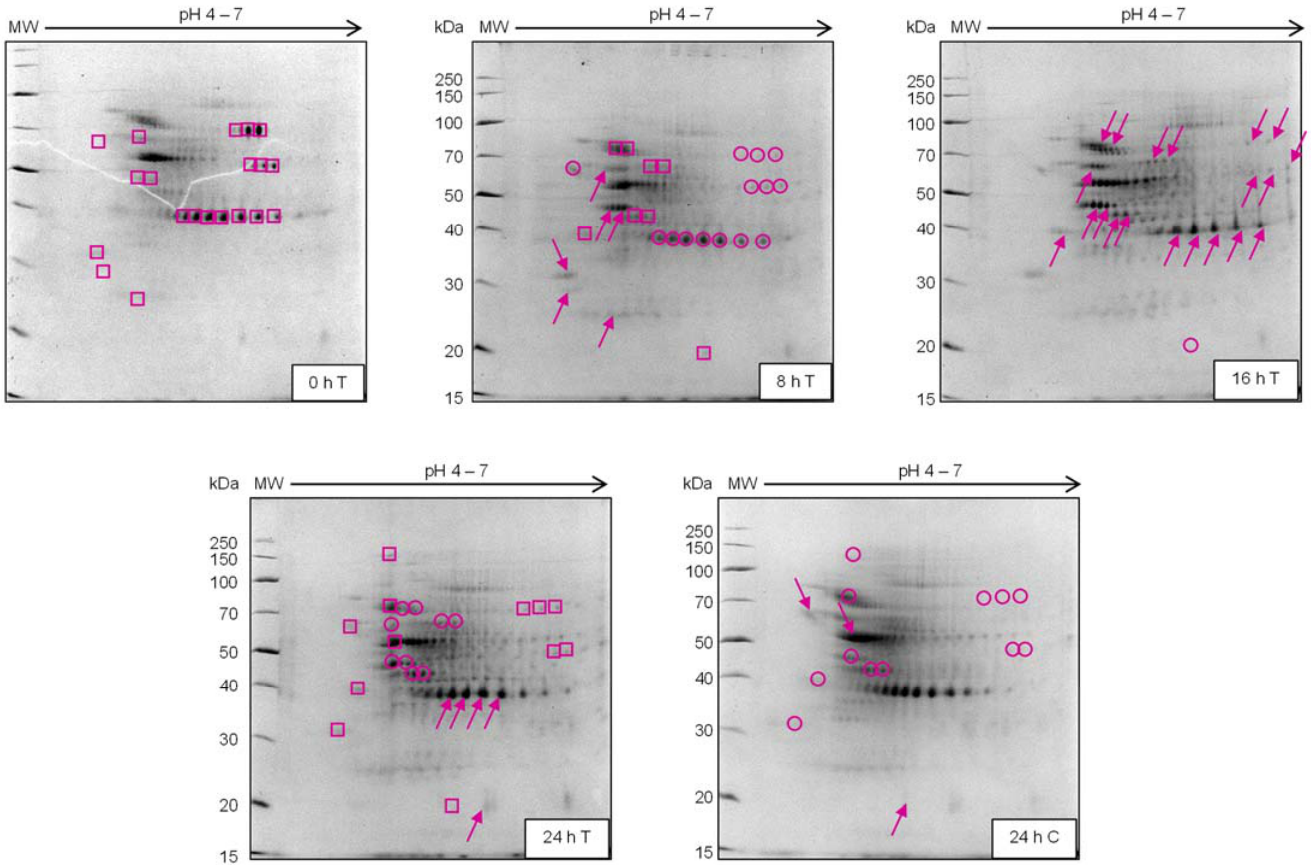
Figure 1. Representative narrow range (pH 4–7) 10% SDS-PAGE two-dimensional gels using 100 µ g of protein isolated from N. tabacum cells treated with 1 mM isonitrosoacetophenone (INAP). Comparative analysis was performed using 0 h as the reference state and each time point thereafter juxtaposed to the previous time point. C, control; T, treated; squares, initial protein state; arrows, up-regulation; circles, down ‐ regulation.